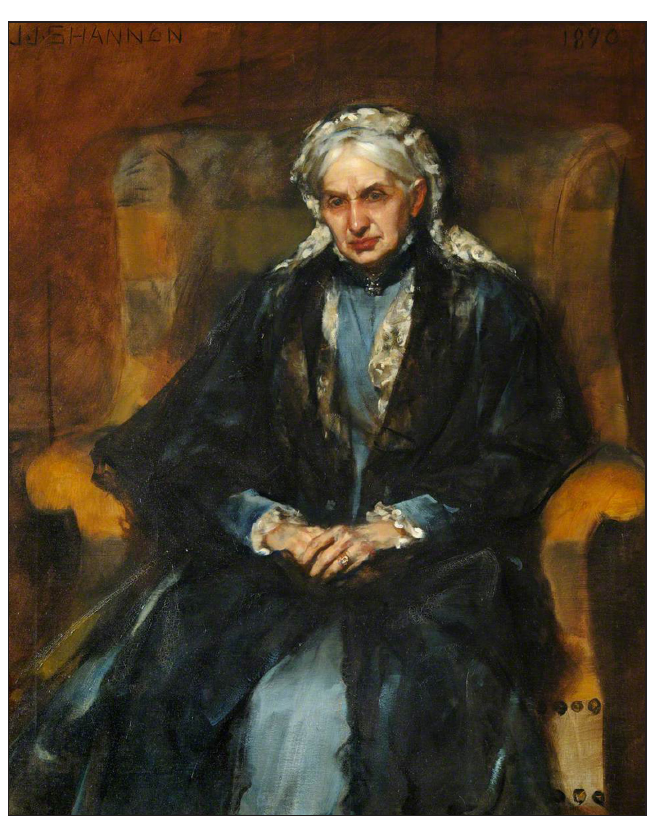
Fig. 4 : James Jebusa Shannon, Anne Jemima Clough, First Principal , 1890, oil on canvas, 127 × 102 cm, Newnham College, University of Cambridge,